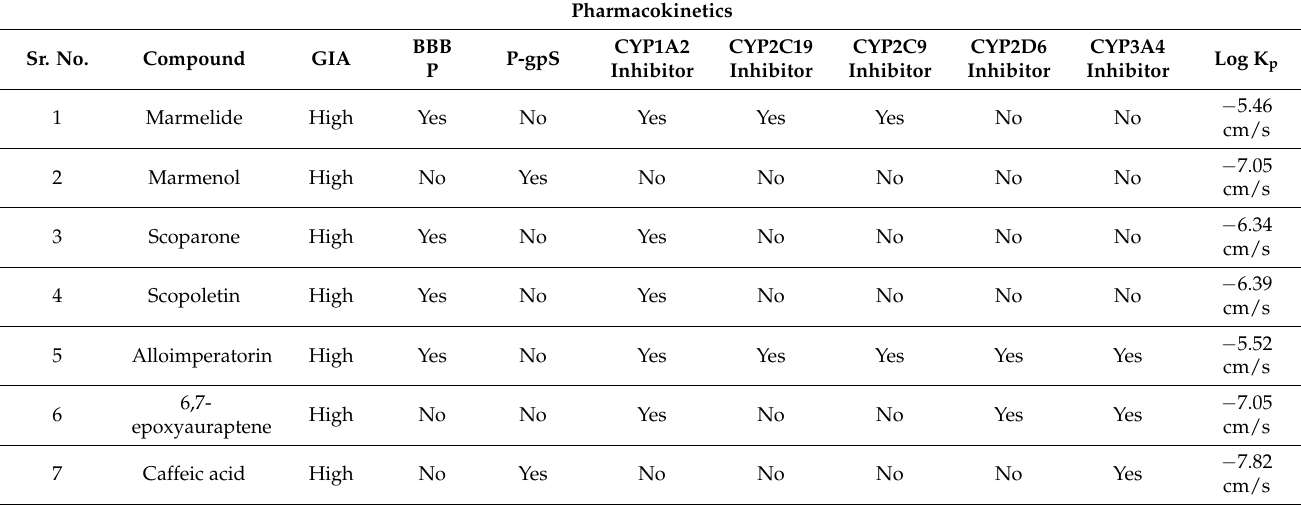
Table 5. Pharmacokinetics prediction of selected compounds of Aegle marmelos .